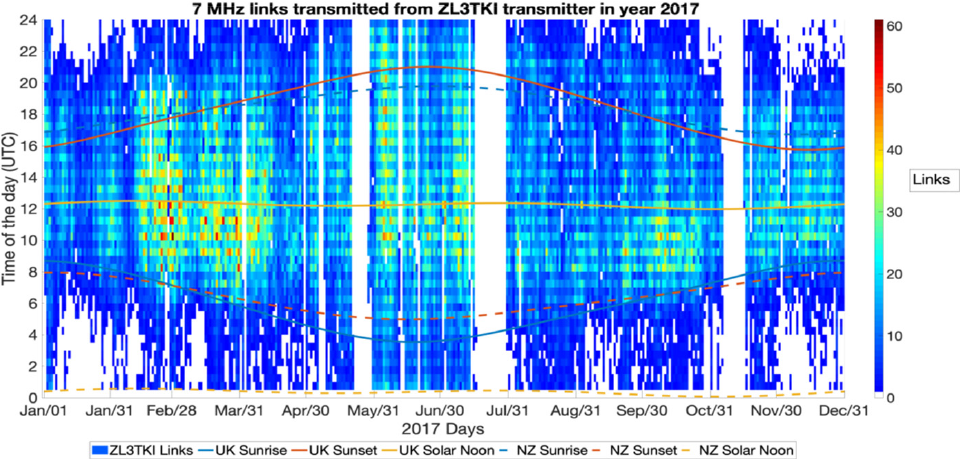
Figure 4. Number of links received from the New Zealand transmitter ZL3TKI in 2017. The colours indicate the number of links made in each half-hour interval.